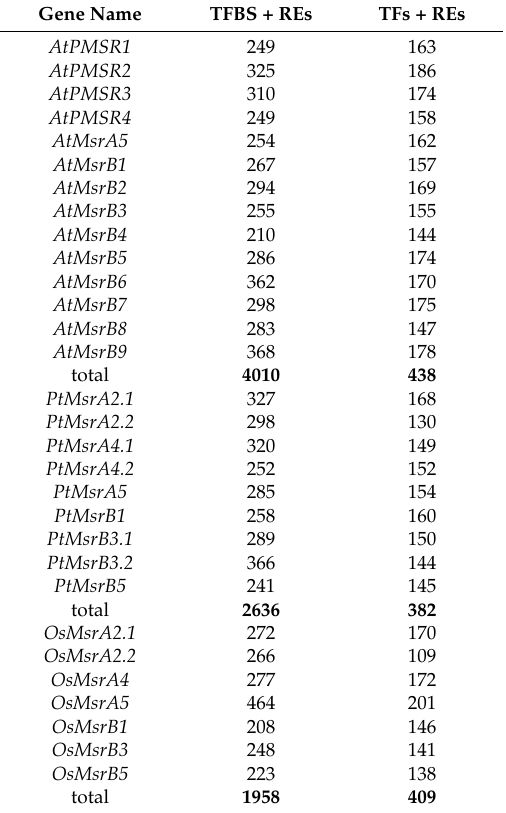
Table 1. Total number of transcription factor binding sites (TFBS) and responsive elements (REs), followed by the number of redundant transcription factors (TFs) and REs predicted for 30 homological genes of methionine sulfoxide reductase type A ( MsrA ) and B ( MsrB ) originating from the Arabidopsis thaliana (At), Populus trichocarpa (Pt), and Oryza sativa (Os)